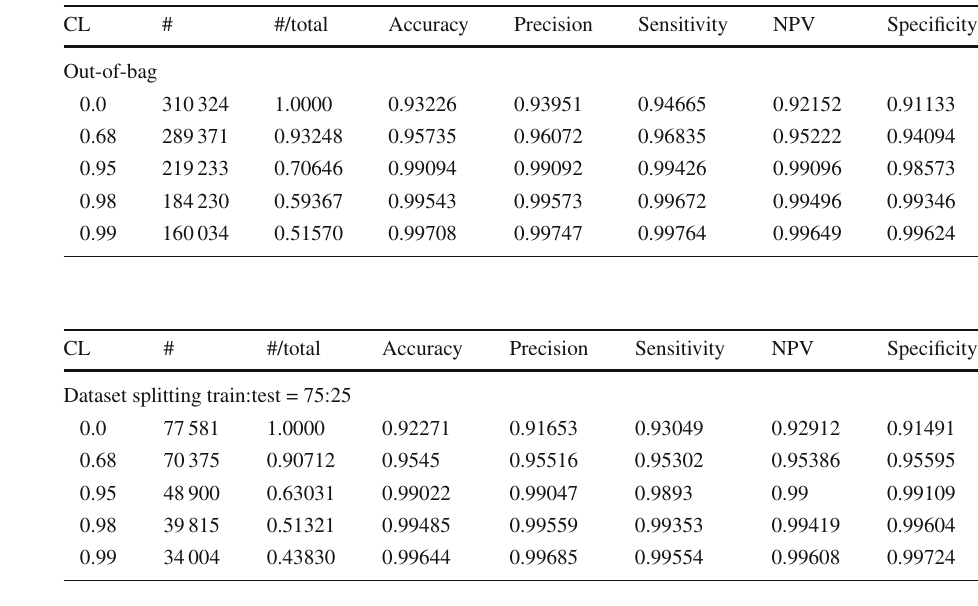
Table 9 Results of the validation of the SUSY-AI classifier with out-of-bag estimation